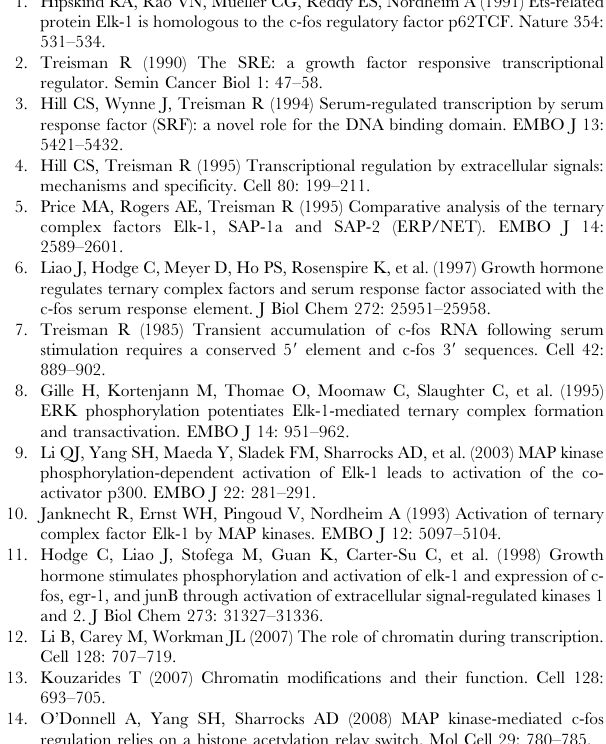
Table S1 PADI4 binding regions identified by ChIP-chip Table S2 Gene ontology analysis for the transactive genes Table S3 Details of PCR primers used for the ChIP-qPCR and RT-qPCR